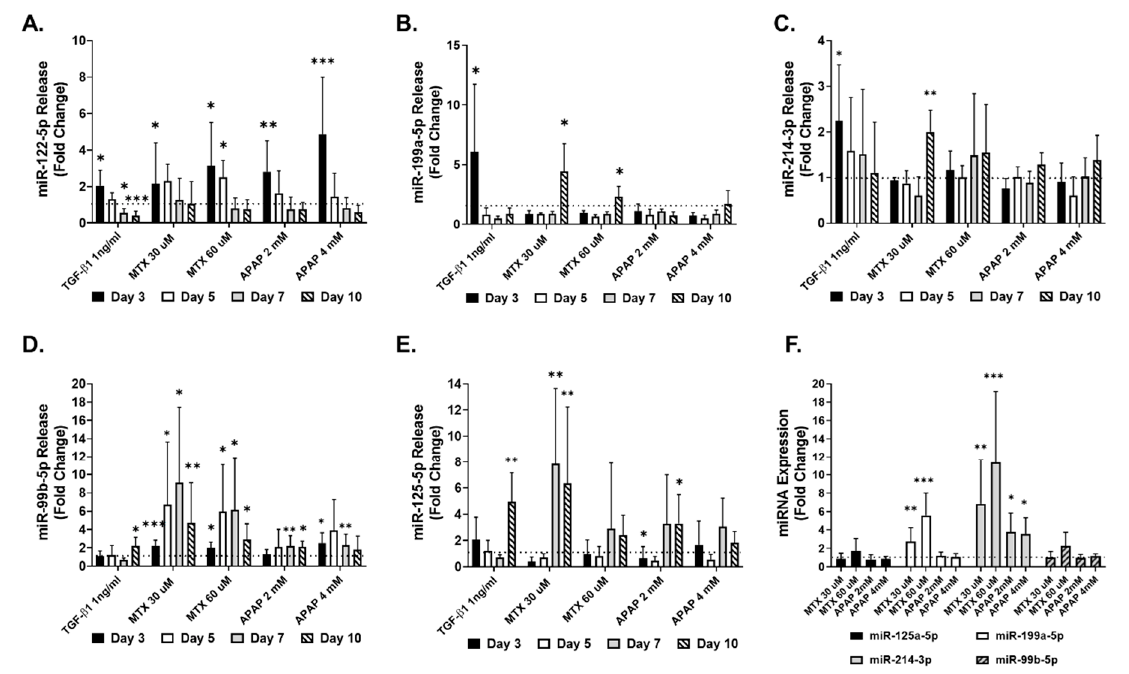
Figure 5. miRNA corroboration using q-RT-PCR. MTs were exposed to TGF- β 1, MTX or APAP for 10 days and cell culture supernatant was collected to investigate miRNA release using q-RT-PCR. Release of miR-122-5p ( A ), miR-199a-5p ( B ), miR-214-3p ( C ), miR-99b-5p ( D ) and miR-125a-5p ( E ) was measured at day 3, day 5, day 7 and day 10, and analyzed using q-RT-PCR. miRNA was also measured intracellularly to assess changes in miR-125a-5p, miR-199a-5p, miR-214-3p and miR-99b-5p expression at day 10 ( F ). Data are expressed as fold change compared to untreated control (fold change 1); n = 9 for A, C, D and E. Bar graphs represent means ± SD; statistical analysis based on Student’s unpaired t test; *, p ≤ 0.05; **, p ≤ 0.01; ***, p ≤ 0.001. Table 1. Literature used for miRNA